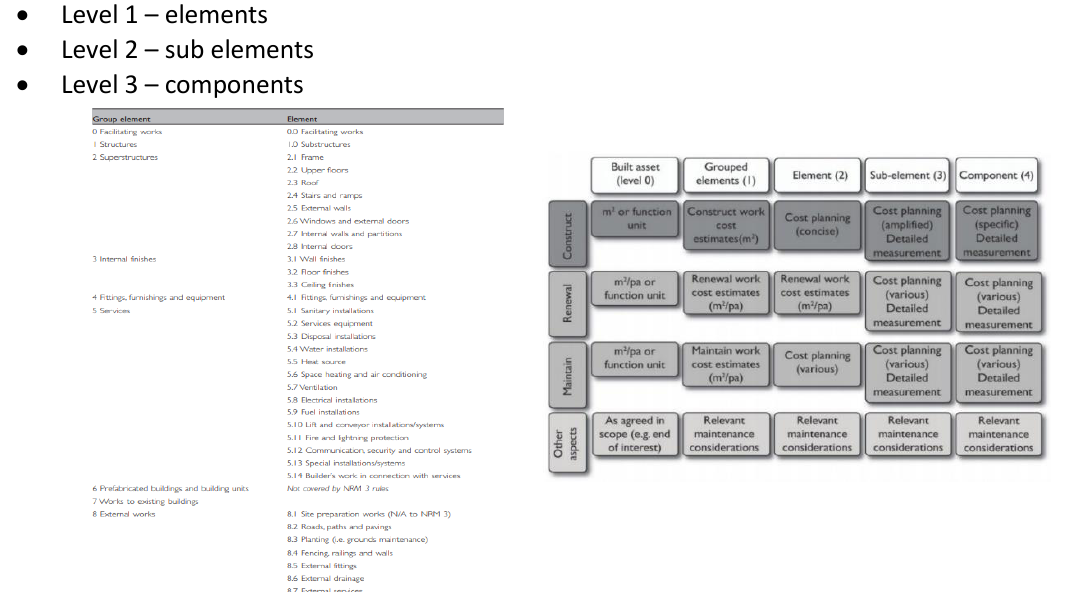
Figure 4: Elemental Method of Cost